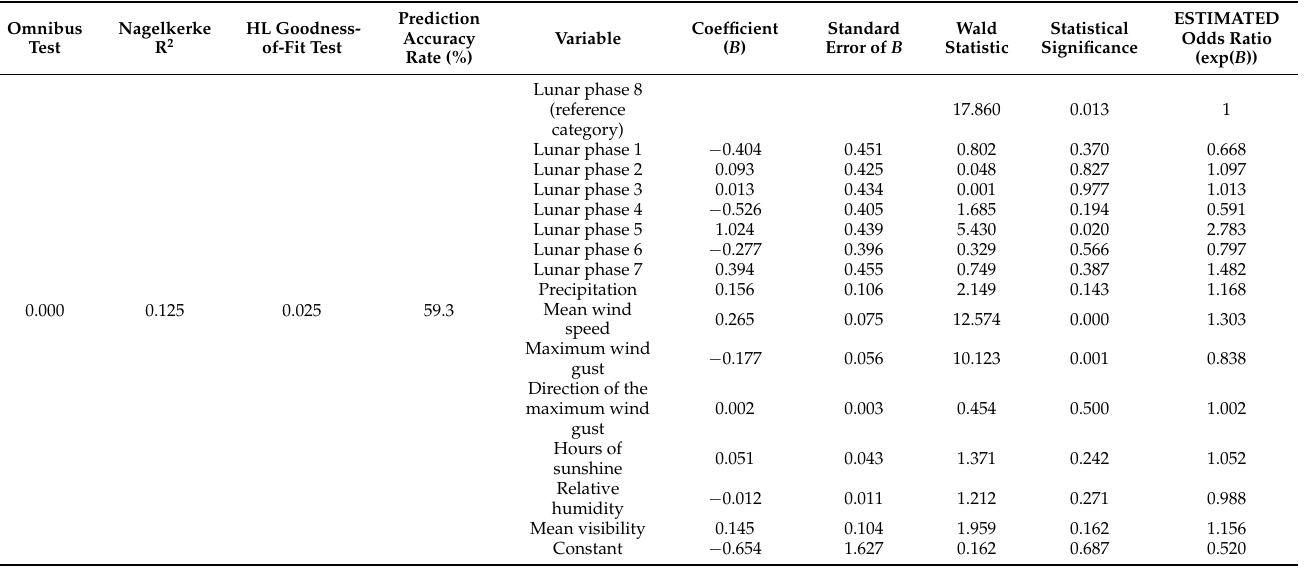
Table 2. Model goodness-of-fit summary statistics and coefficient values for each independent factor in the